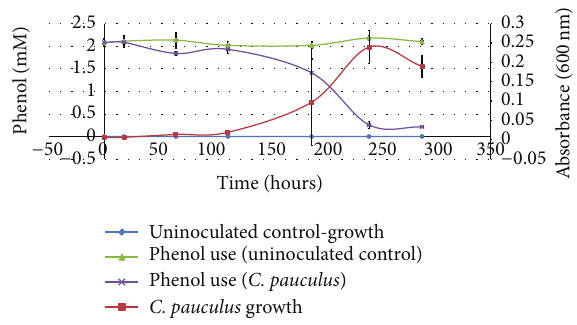
Figure3:Growthof C.pauculus UM1withphenolasthesolecarbon source. (For both the growth of C. pauculus UM1 and the amount of phenol remaining in the media, significant differences ( 𝑃 ≤ 0.01 ) were noted for 244 and 288 hours.) Error bars represent the standard deviation of a